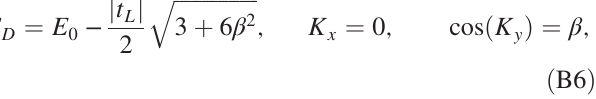
FIG. 8. (a) Measured dispersion along the k 2 π = ð d 0 þ d= 2 Þ for β ¼ 0 . 45 (same as Fig. 3). (b) Data points extracted from the Dirac point marked in a dashed rectangle in panel (a). From linear fits to the points, we obtain j v 0 plotted in Fig.